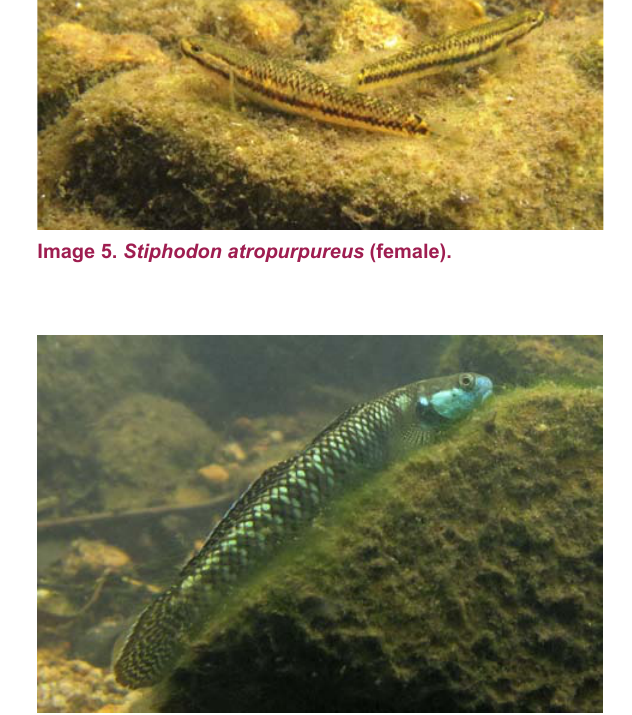
Image 7. Stiphodon imperiorientis (male). Image 8. Stiphodon multisquamus (male).